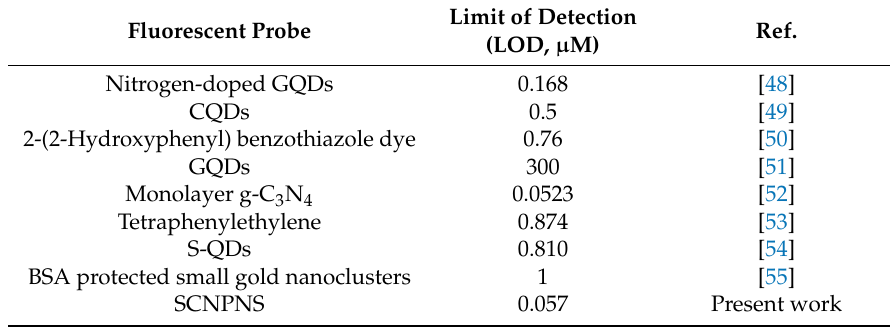
Table 1. Limit of detection (LOD) comparison between the present method and previously reported methods for Ag + detection.